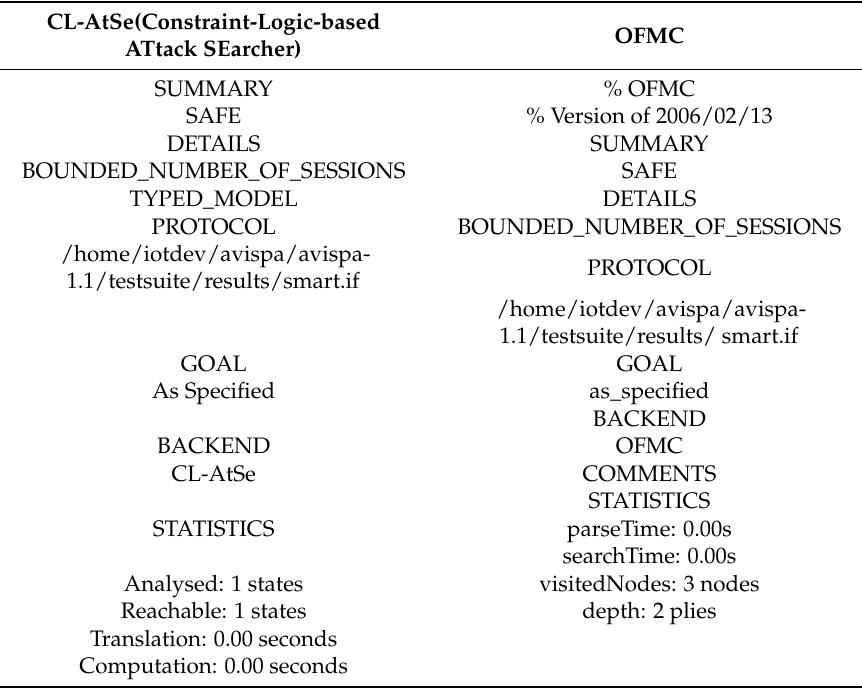
Table 7. Simulation results of